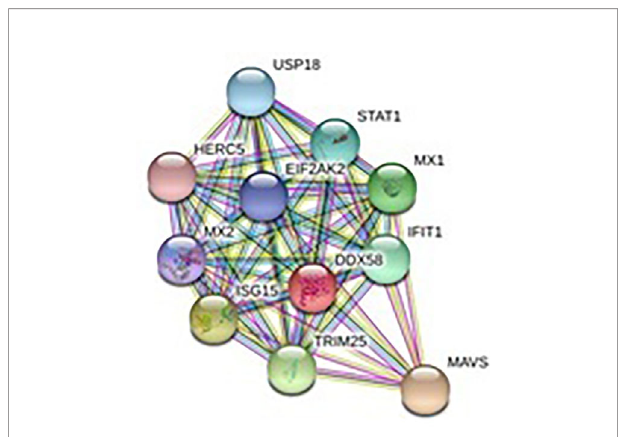
FIGURE 4 | Protein – protein interaction network of RIG-I gene with associated protein by STRING